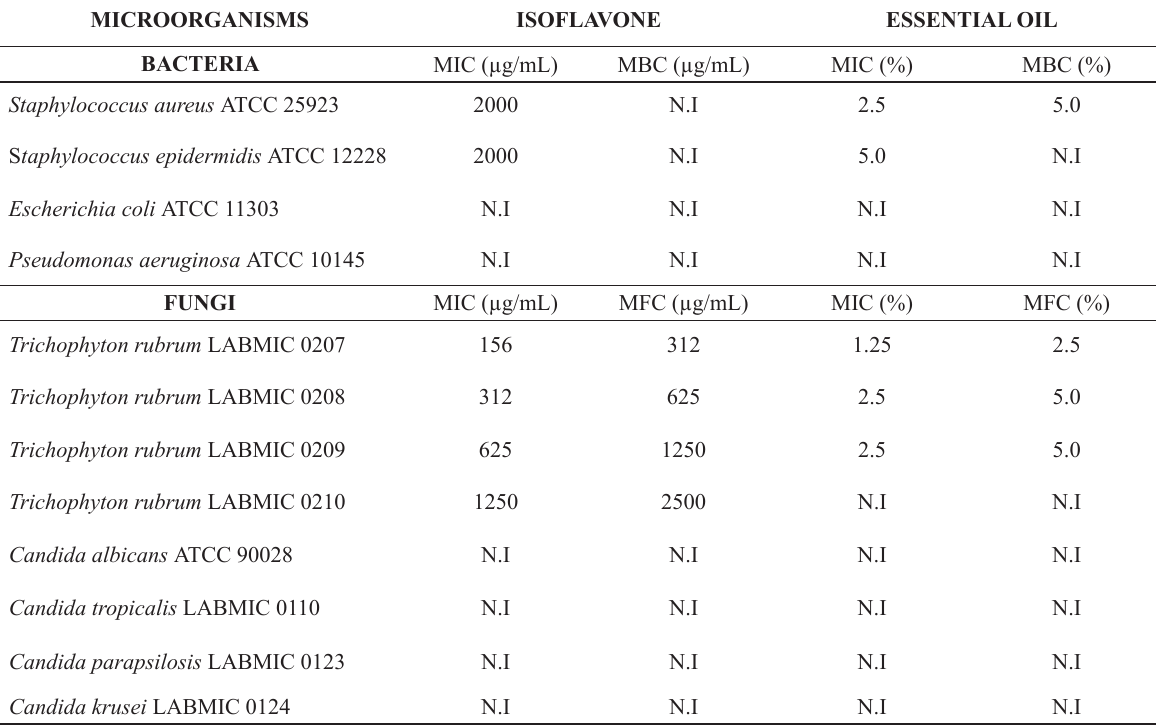
Antibacterial and antifungal activities of the isoflavone and essential oil from Myroxylon peruiferum L.f. MICROORGANISMS ISOFLAVONE ESSENTIAL OIL